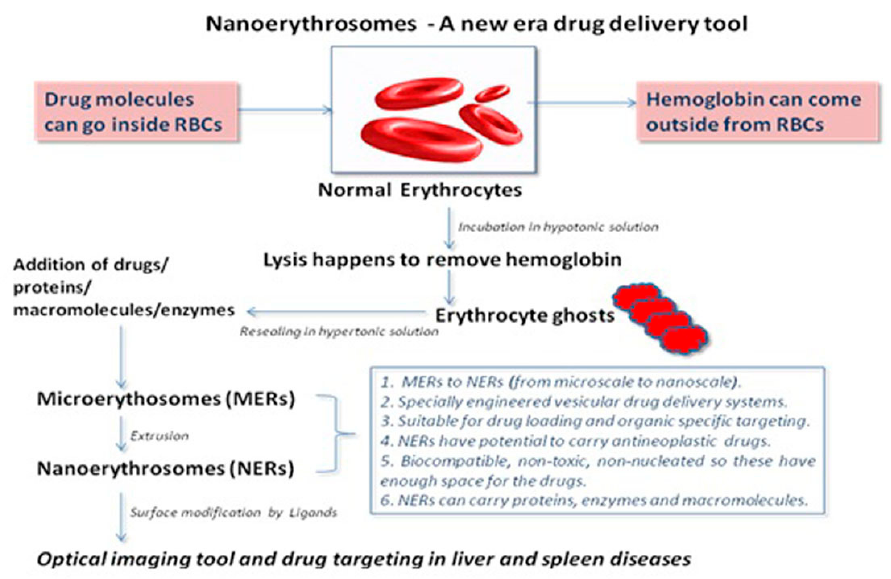
Figure 1. Preparation of nanoerythrocytes (NER) from normal erythrocytes (ER).